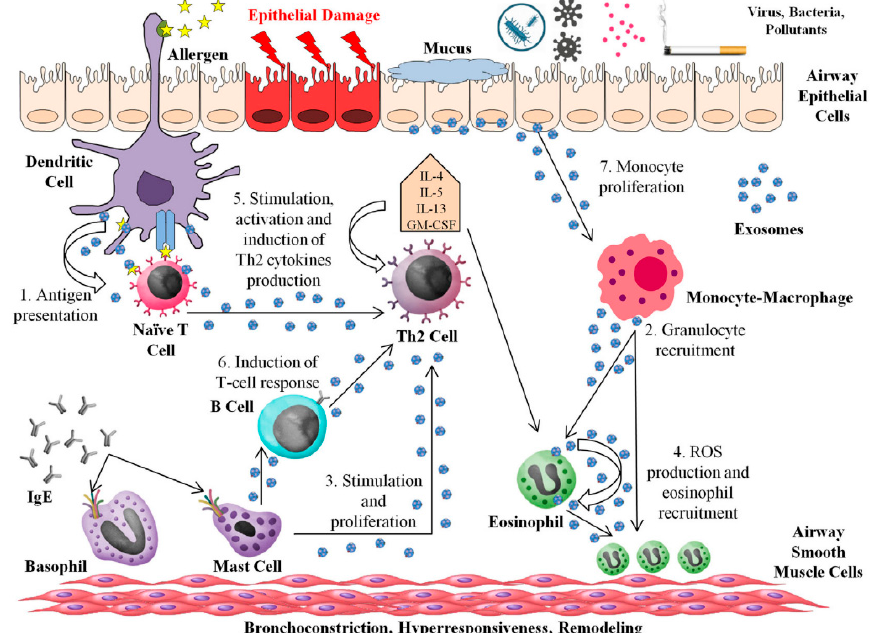
Figure 3. Schematic representation of the role of exosomes in allergy and asthma. This image is reproduced from reference [51]. The original publication was published under Creative Commons Attribution License (CC BY), 2017, Frontiers.